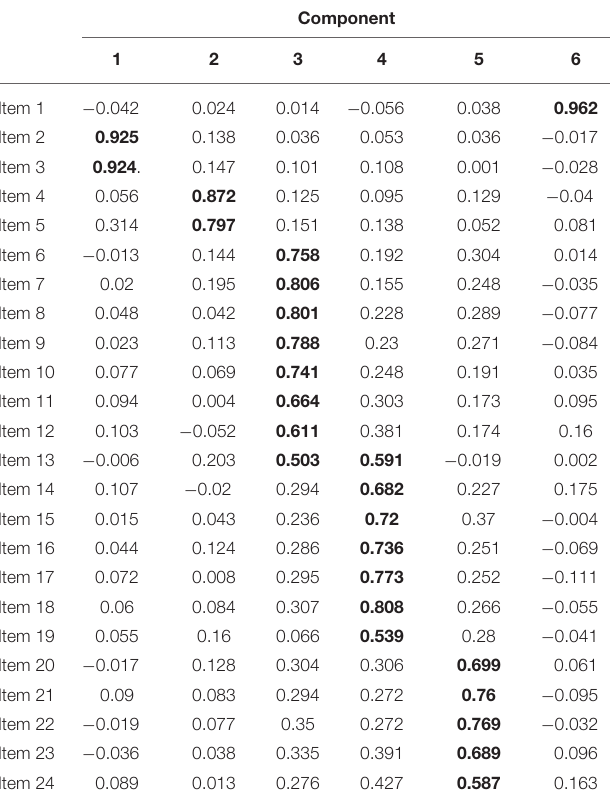
TABLE 3 | Rotated component